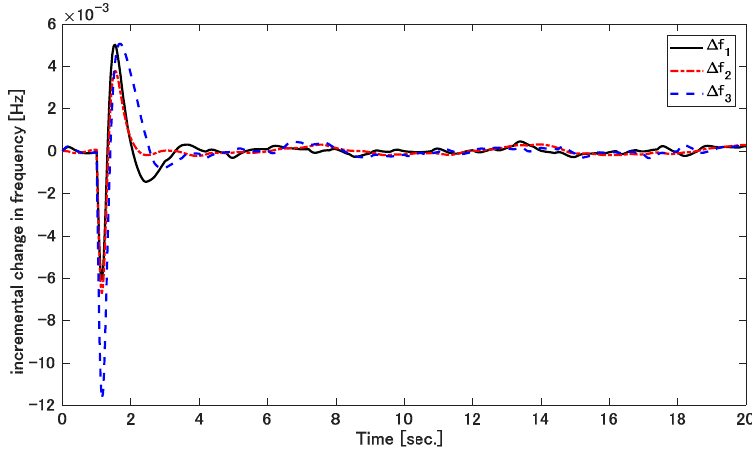
Figure 9. Frequency deviation of three-area power system with a wind plant.